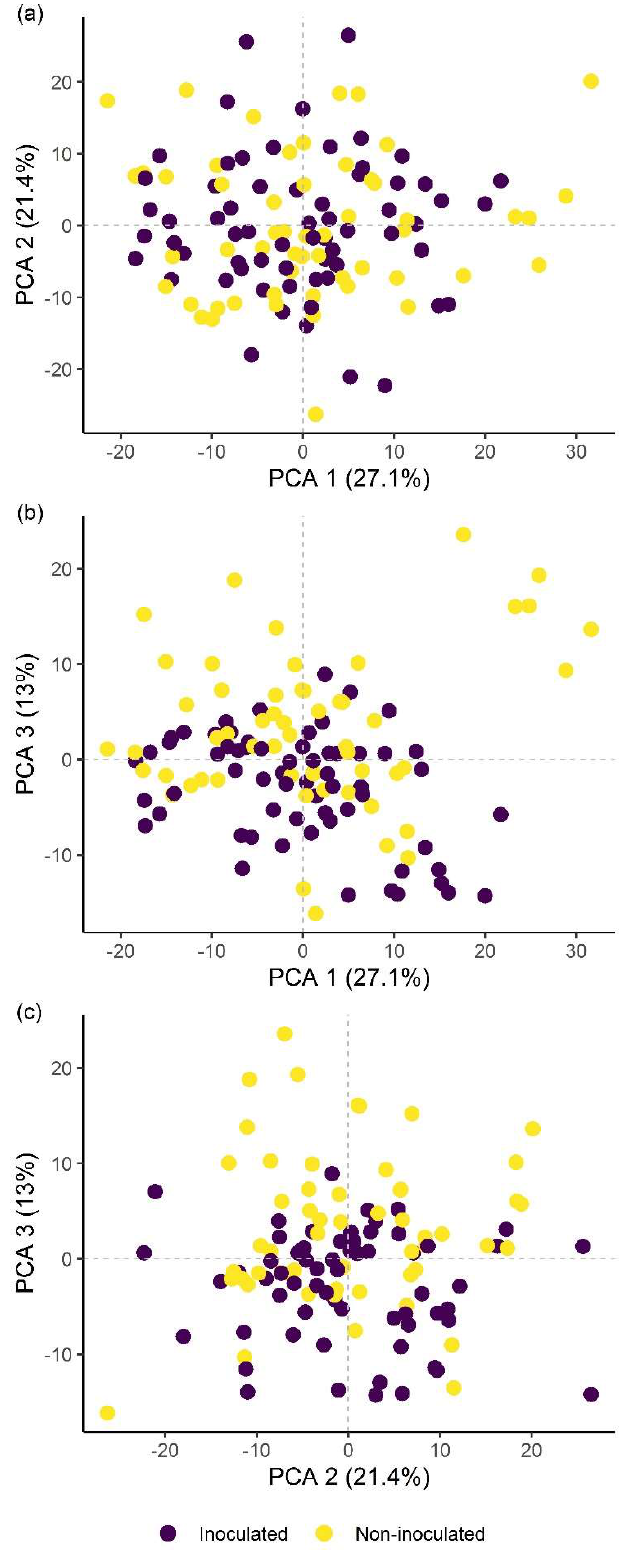
Figure 5. Principal component analysis (PCA) score plots showing the variation in plant groups from the pot experiment in Bacillus firmus -inoculated (BfL and BfH) or non-inoculated plants (NC and PC). The first three principal components (PCA 1, 2 and 3) explain more than 60% of the observed variability and are presented in the combinations ( a ) PCA 1–2; ( b ) PCA 1–3; and ( c ) PCA 2–3. NC—negative control; PC—positive control (nematicide); BfL—low B. firmus inoculum; BfH—high B. firmus inoculum.